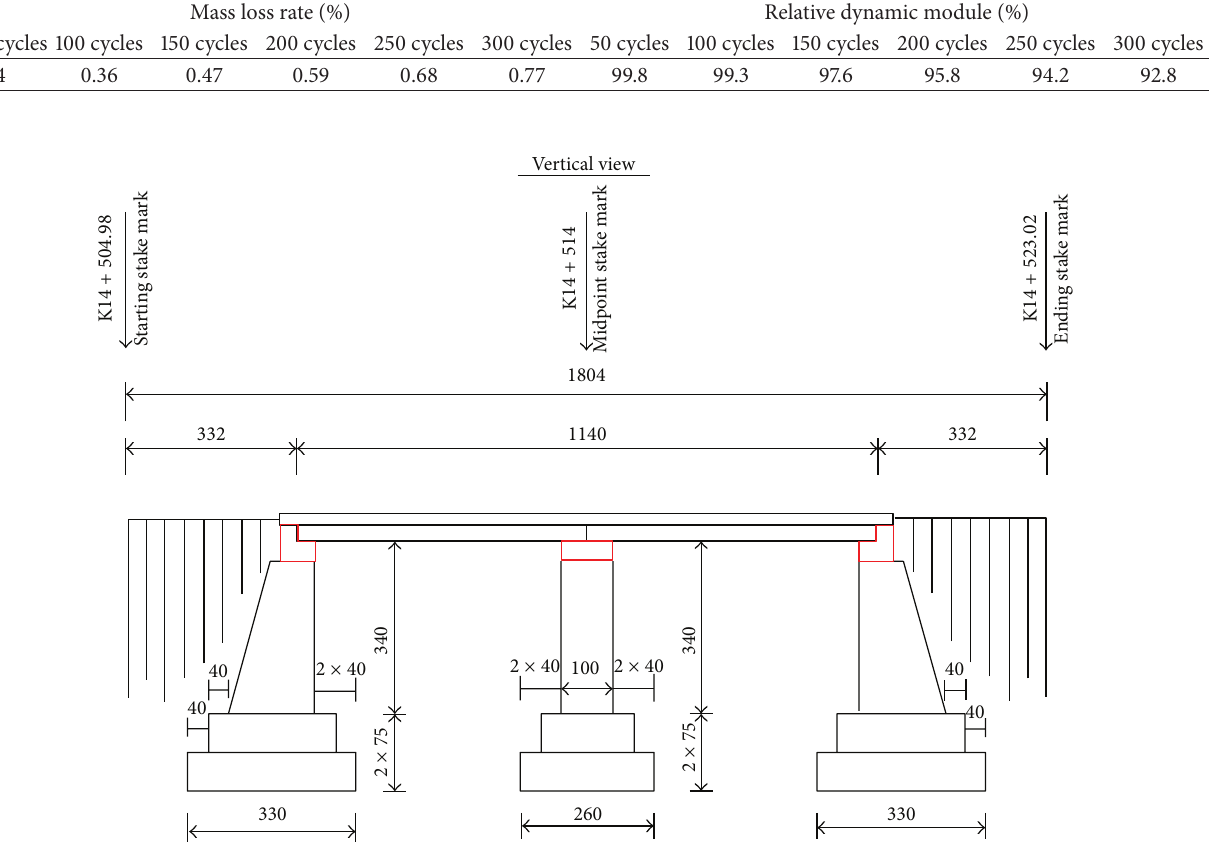
Figure 4: Front view of Xialouzi Bridge.